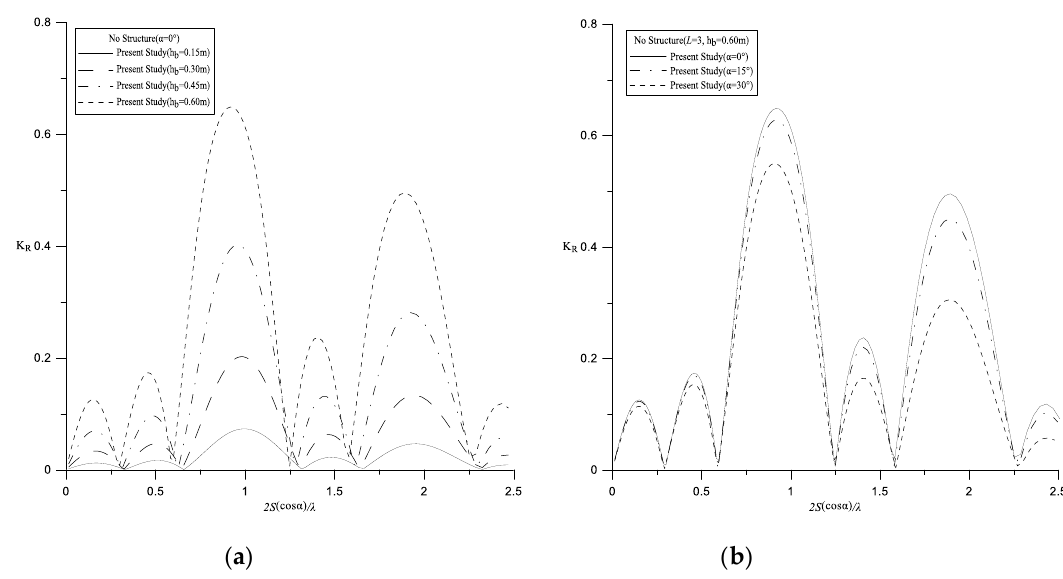
Figure 12. The reflection coefficients for Bragg reflections over periodic parabolic breakwaters of ( a ) different heights and ( b ) different incidence angles.